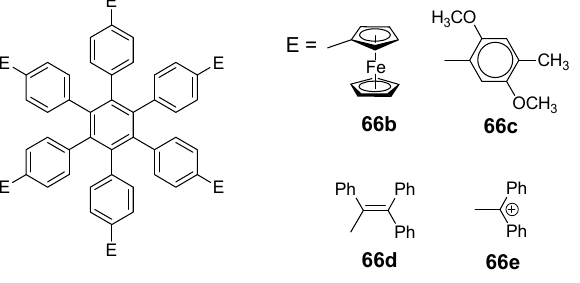
Figure 25. Hexaphenylbenzene derivatives with electrochemically active peripheral